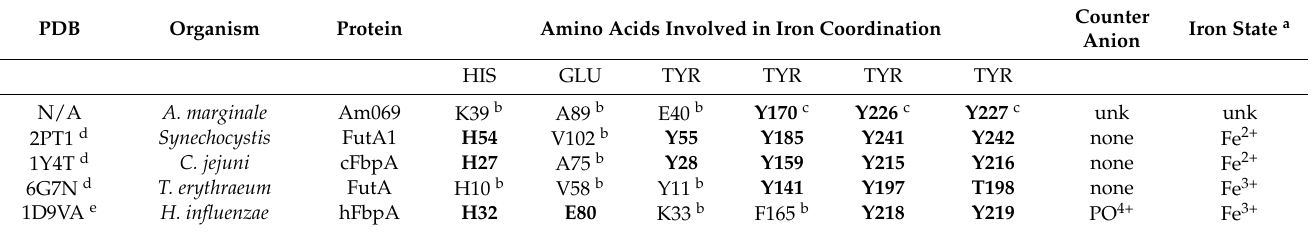
Table 1. Proteins with the best structural similarity to Am069 and their iron-coordinating amino